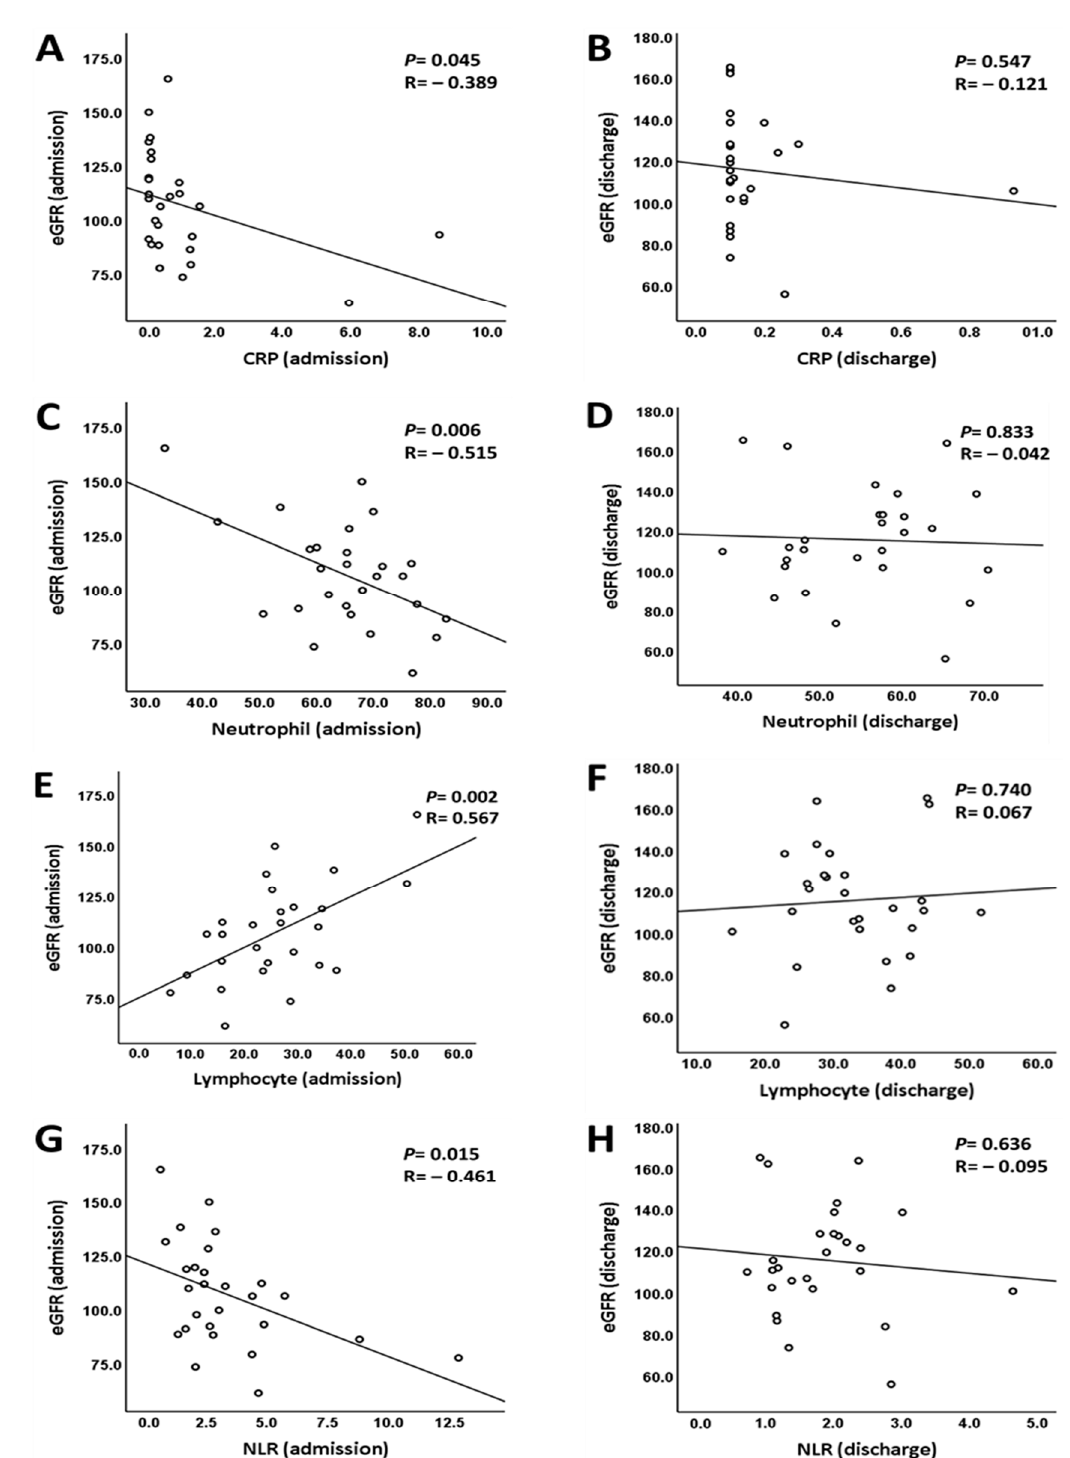
Figure 2. Correlation between renal function and the severity of infection. ( A ) Correlation between CRP and eGFR upon admission, the adjusted p value = 0.152 after adjustment for neutrophil and lymphocyte counts upon admission. ( B ) Correlation between CRP and eGFR at discharge. ( C ) Correlation between neutrophil count and eGFR upon admission, the adjusted p value = 0.240 after adjustment for CRP and lymphocyte count upon admission. ( D ) Correlation between neutrophil count and eGFR at discharge. ( E ) Correlation between lymphocyte count and eGFR upon admission, the adjusted p value = 0.071 after adjustment for lymphocyte count and CRP upon admission. ( F ) Correlation between lymphocyte and eGFR at discharge. ( G ) Correlation between NLR and eGFR upon admission, the adjusted p value = 0.037 after adjustment for CRP upon admission. ( H ) Correlation between NLR and eGFR at discharge.